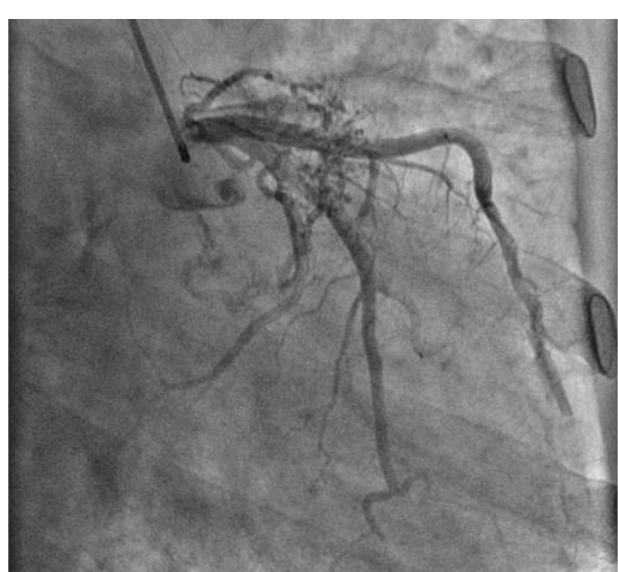
Fig. 1 – Right anterior oblique caudal view showing the fistulae originating from the left circumflex artery.